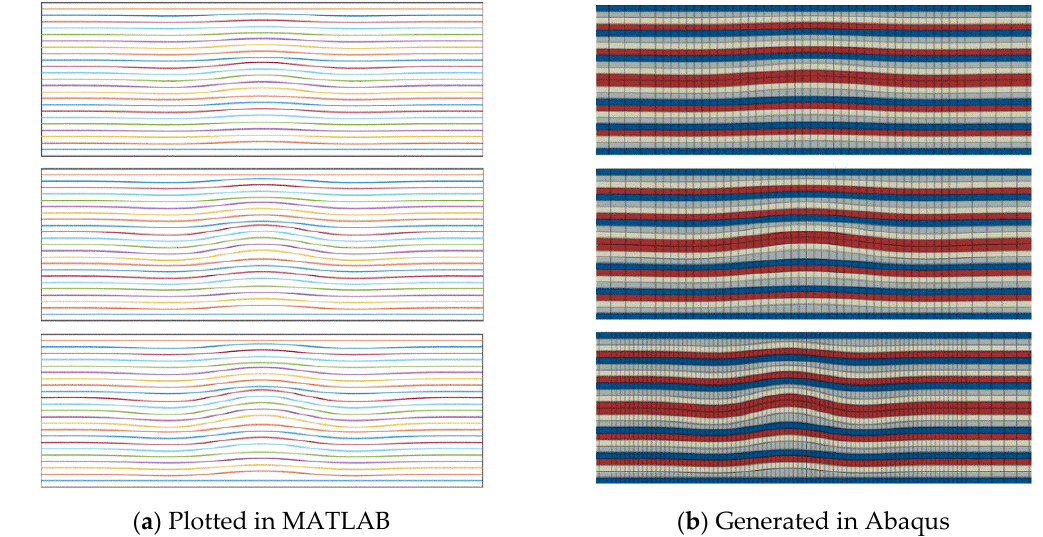
◦ , 9.9 ◦ , and 11.4 ◦ from top to Figure 9. Section of wrinkle level 5.6°, 9.9°, and 11.4° from top to bottom. Figure 9. Section of wrinkle level 5.6